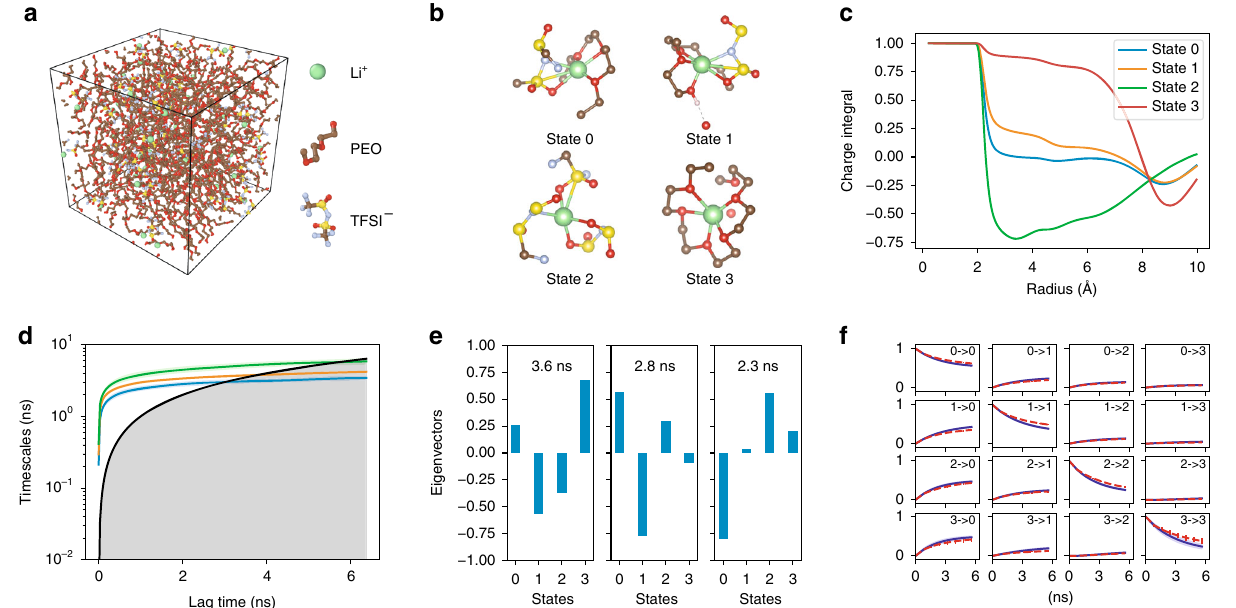
Fig. 4 A four-state dynamical model learned for lithium ion in a PEO/LiTFSI polymer electrolyte. a Structure of the PEO/LiTFSI polymer electrolyte. b Representative con fi gurations of the four Li-ion states learned by the dynamical model. c Charge integral of each state around a Li-ion as a function of radius. d Relaxation timescales computed from the Koopman models as a function of the lag time. The black lines are reference lines where the relaxation timescale equals to the lag time. e Eigenvectors projected to each state for the three relaxations of Koopman models at τ = 0.8 ns. f CK test comparing the long-time dynamics predicted by Koopman models at τ = 0.8 ns (blue) and actual dynamics (red). The shaded areas and error bars in d , f report the 95% con fi dence interval from four independent trajectories in the test data